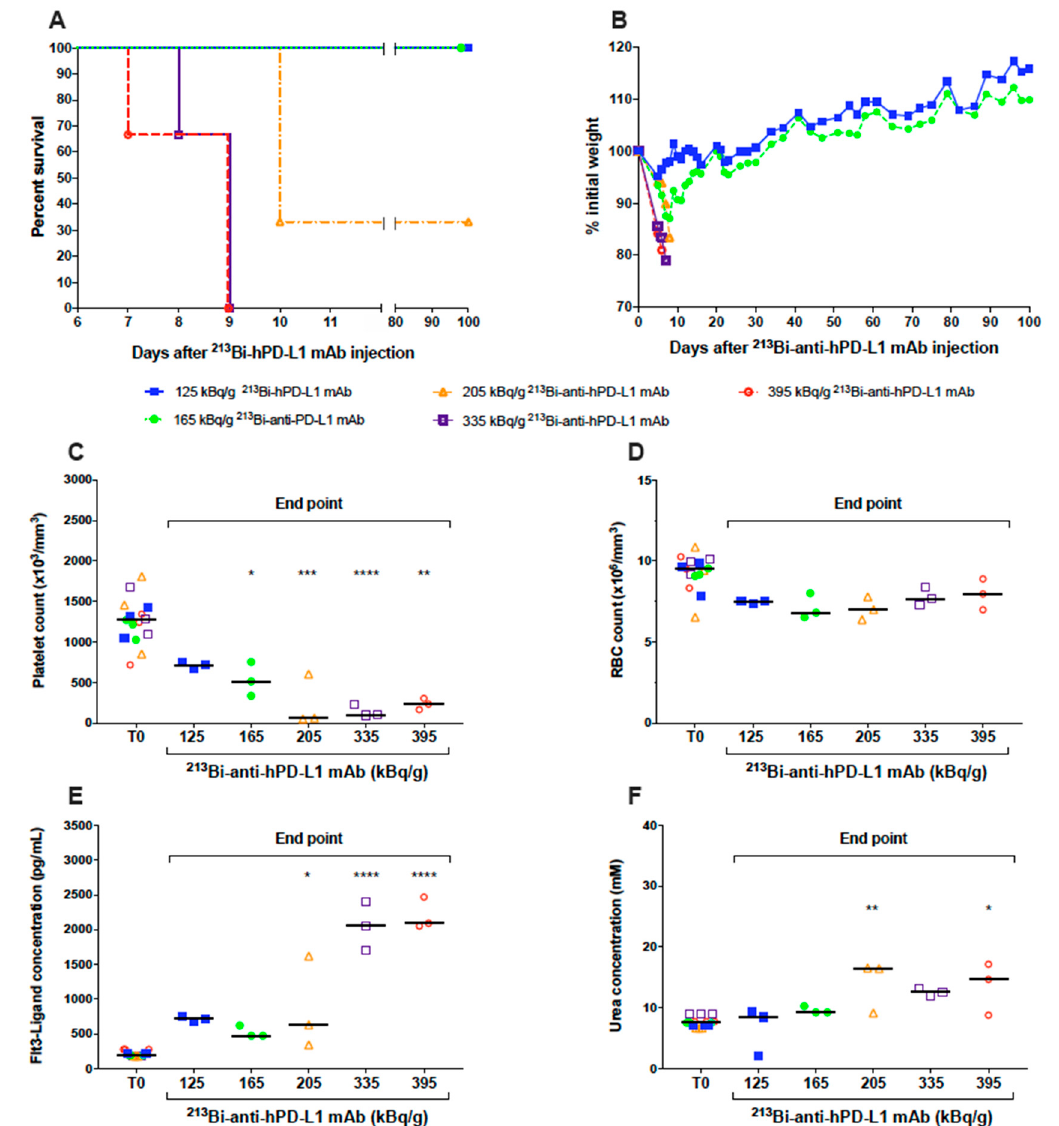
Figure 3. Dose-escalation study of 213 Bi-anti-hPD-L1. Naive NSG mice ( n = 3 per group) received an i.v. injection of 125 ( ), 165 ( ), 205 ( ), 335 ( ), 395 ( ) kBq/g 213 Bi-anti-hPD-L1 mAb. ( A ) Kaplan–Meier survival analysis. ( B ) Mean weight variation in each group, as expressed as percent of initial weight. Activities ranging from 205 to 395 kBq/g 213 Bi-anti-hPD-L1 mAb induced acute toxicity as demonstrated by weight loss > 20% of initial weight and resulting in mouse sacrifice. Animals surviving acute toxicity were followed for a 100-day period before euthanasia. ( C ) Platelet, ( D ) RBC counts, as well as ( E ) plasma FLT3-Ligand and ( F ) urea concentrations were monitored for each animal before injection of radiolabeled anti-hPD-L1 mAb (T0) and at end point. Each sample was assessed in duplicate. Bar represents the median. Activities ranging from 205 to 395 kBq/g 213 Bi-anti-hPD-L1 mAb induced significant toxicity on platelets (* p = 0.0297, ** p = 0.0023, *** p = 0.0001, **** p < 0.0001), bone marrow (* p = 0.0163, **** p < 0.0001), and kidneys (* p = 0.0297, ** p = 0.0045). Statistical analysis was performed with two-way ANOVA followed by Sidak’s multiple comparison